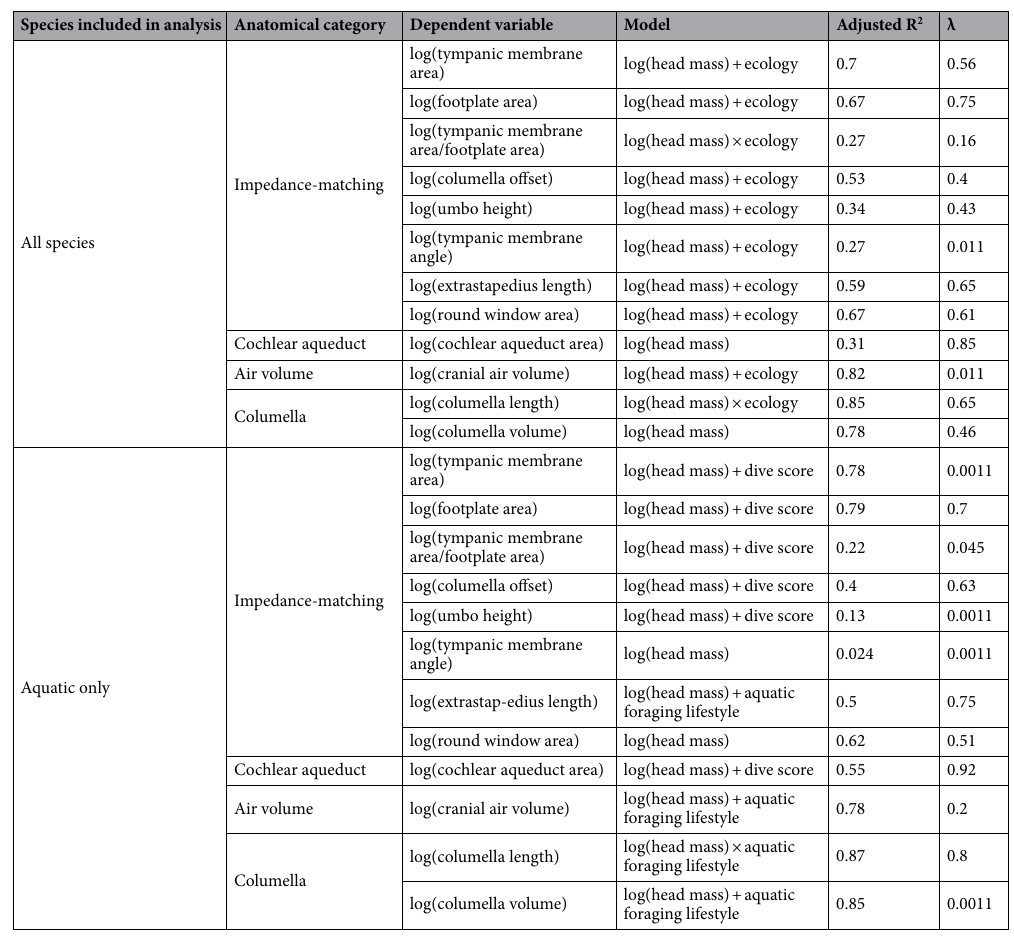
Table 1. Best supported PGLS models from AIC analysis, with adjusted R 2 and Pagel’s λ, a measure of phylogenetic